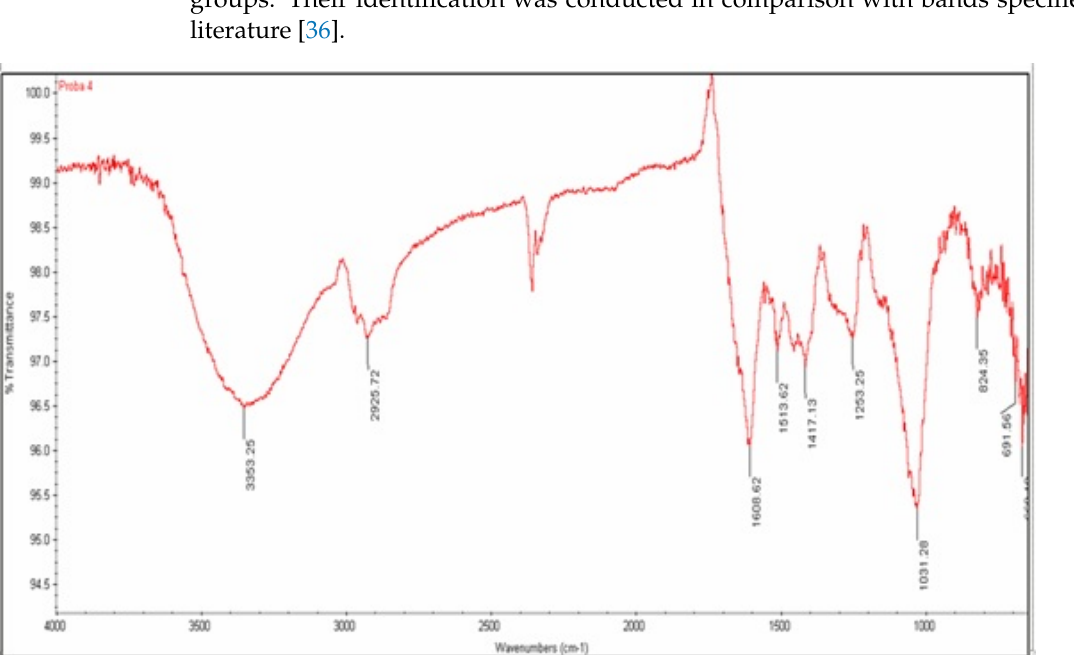
( ν C-O = 1050–1250 cm − 1 ). Alkane chains and ester groups denote the lipids, since